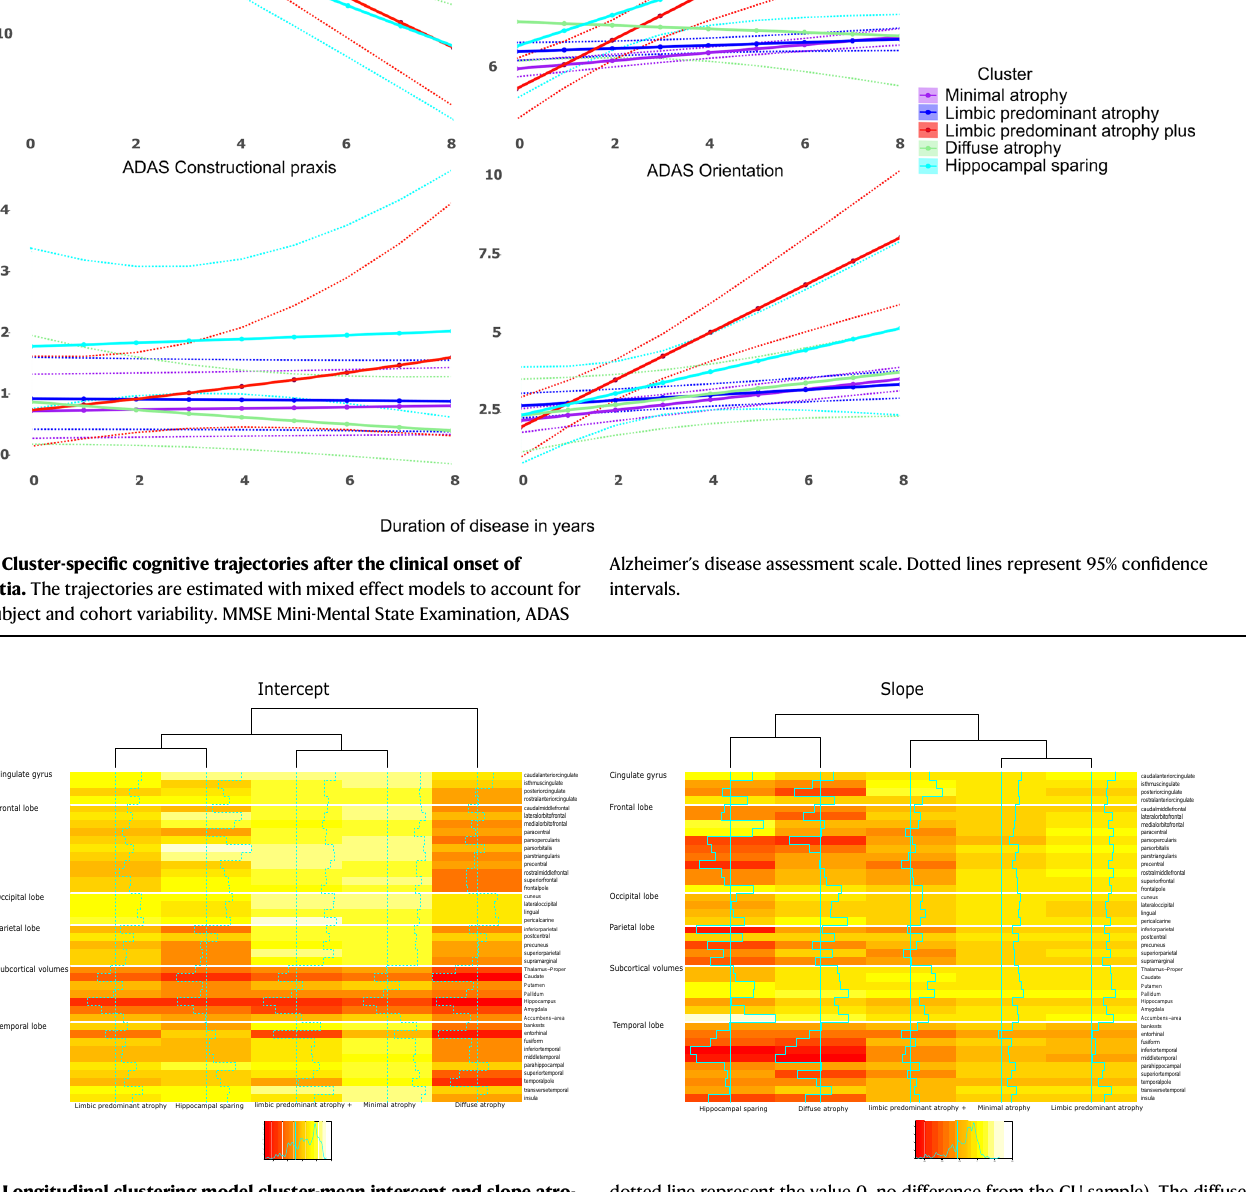
dotted line represent the value 0, no difference from the CU sample). The diffuse atrophyclusterhasthelowestinterceptanditisnotgroupedwithanyothercluster. The cluster slopes of the diffuse atrophy and hippocampal sparing clusters are grouped together. The minimal atrophy and limbic predominant atrophy/Limbic predominant plus are grouped